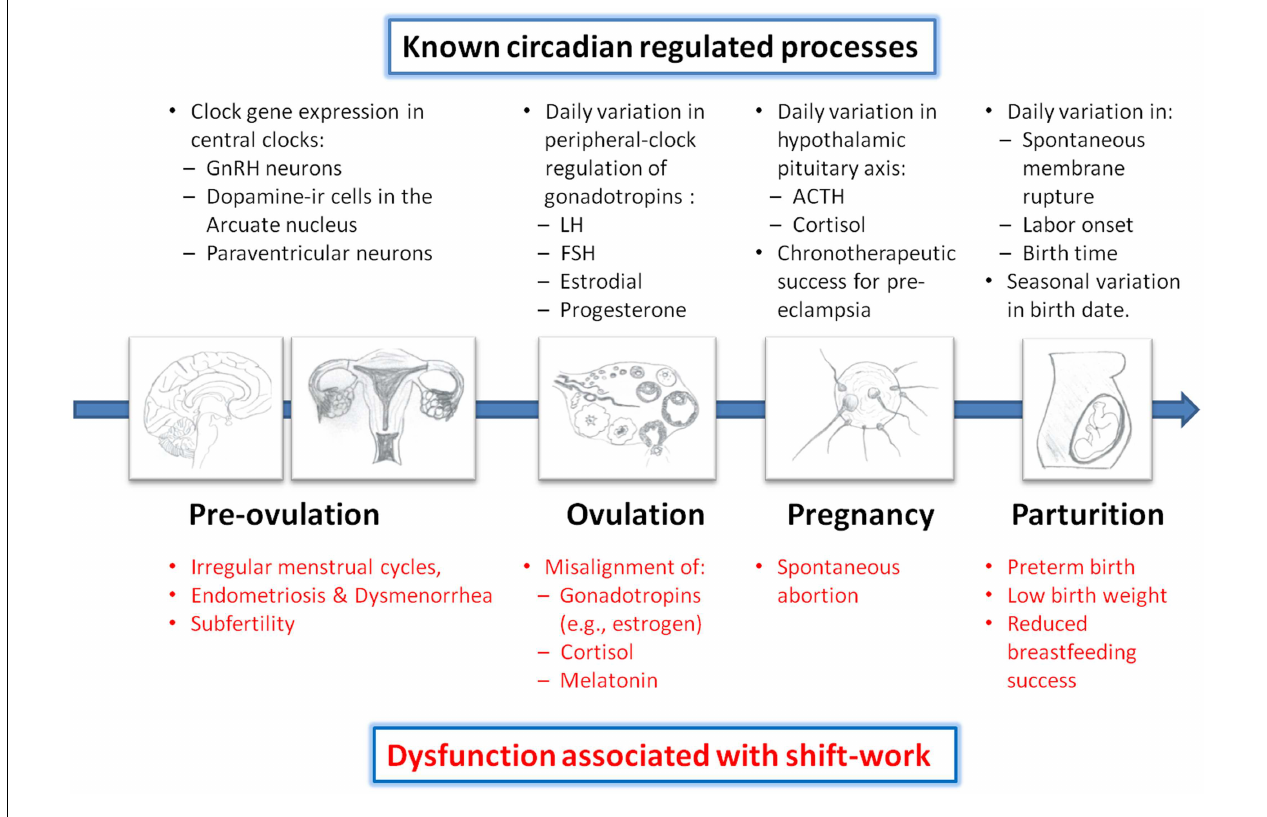
rhythms, as often occurs with shift work, results in increased risk of adverse consequences at each step of the reproductive pathway. See text for references. GnRH, gonadotropin releasing hormone; LH, luteinizing hormone; FSH, follicle stimulating hormone; ACTH, adrenocorticotropic